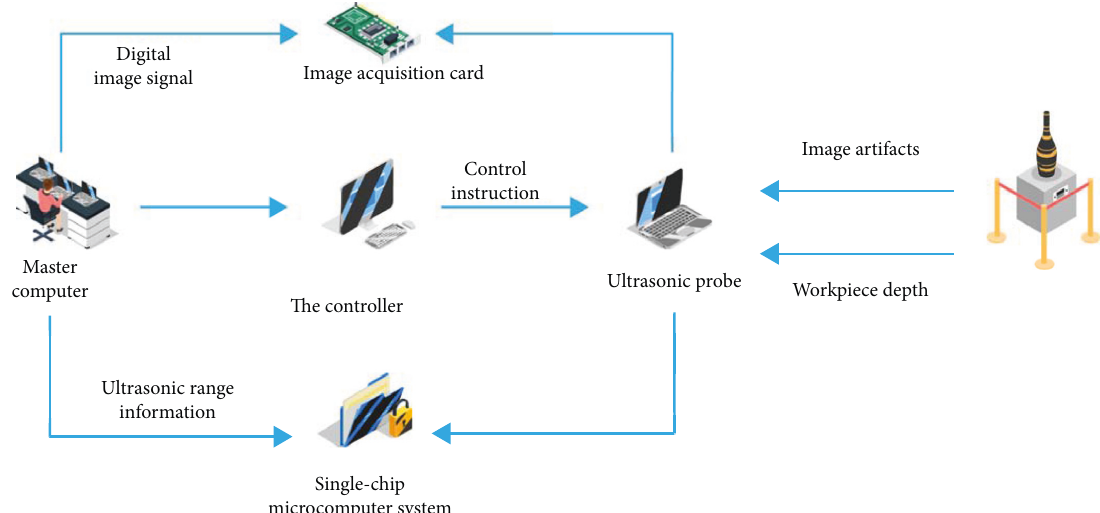
Figure 1: Extraction of ceramic sculpture artwork